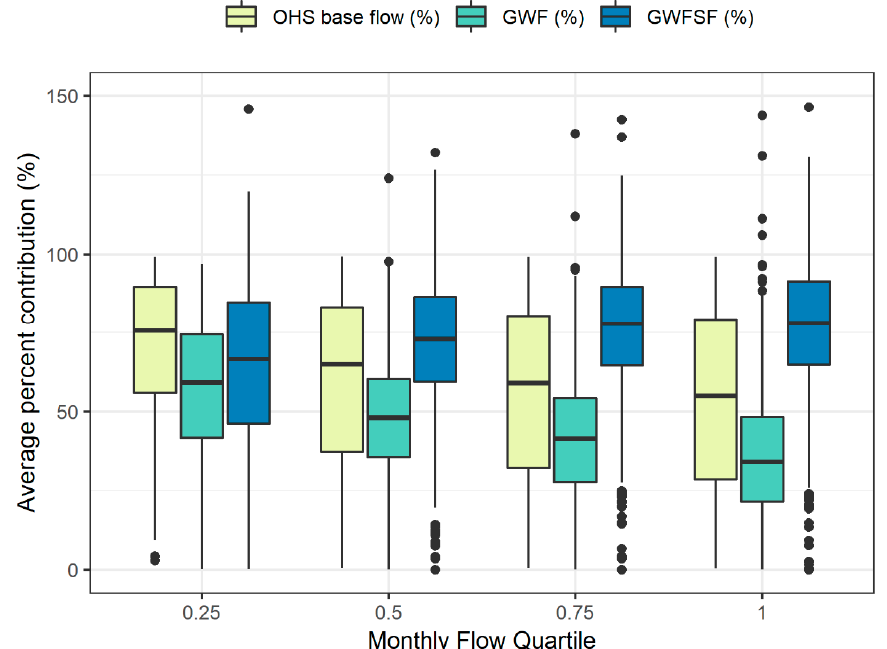
Figure 9. Average monthly percent contribution to total flow of OHS base flow, GWF, and GWFSF over normalized monthly flow quartiles (0.25, 0.5, 0.75, 1). Values greater than 100 percent are due to the comparison of HRU-based volumes with routed-based stream segment volumes (n = 6 out of 662